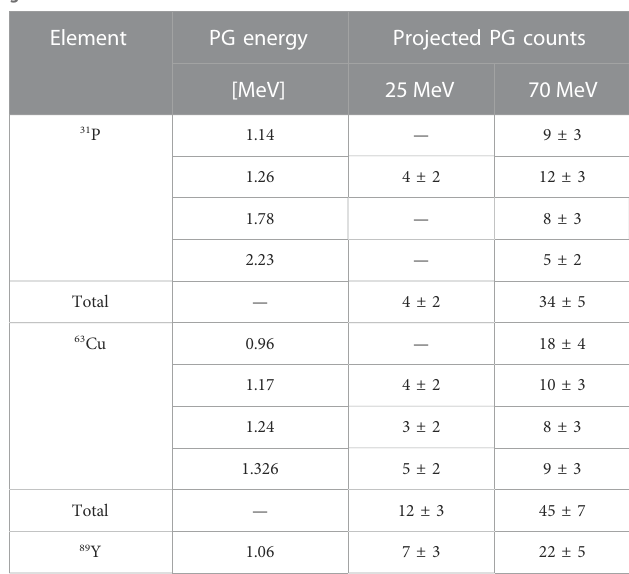
TABLE 4 Expected count of signature PGs generated by 25 and 70 MeV beams, with the following conditions: 0.4 mM element concentration in the tumor, 10 9 protonsdeliveredandadetectionapparatuscovering5sr.Thevaluesfor0.4 mM have been obtained either by scaling the data at the measured concentration (25 MeV) or using the parameter b of Table 3 (70 MeV). The uncertainties on the single gamma lines are assessed as the square root of the counts, while the error propagation on the sum was considered for the total number of projected